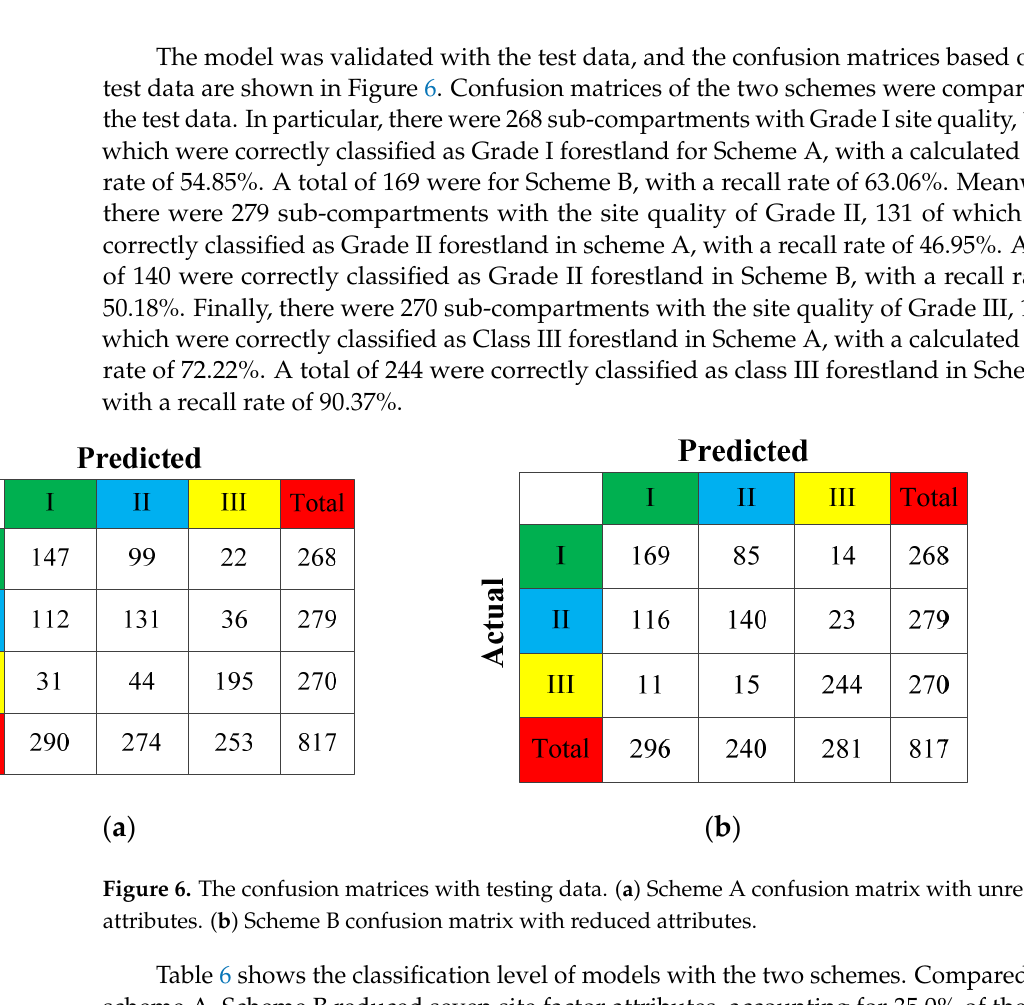
Figure 5. The confusion matrices with training data. ( a ) Scheme A confusion matrix with unre- duced attributes. ( b ) Scheme B confusion matrix with reduced attributes.